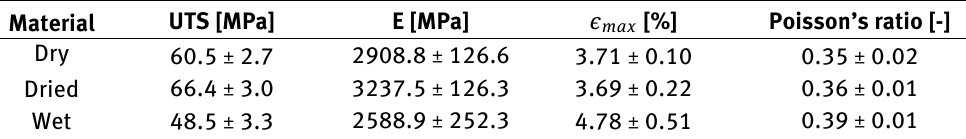
Table 1: Mechanical and elastic properties of dry, wet and dried epoxy.